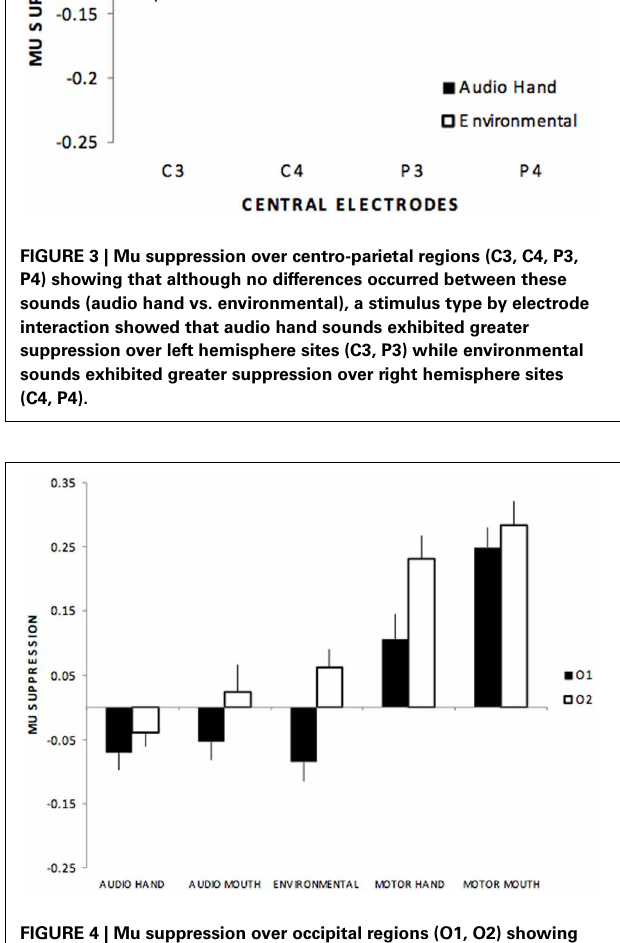
FIGURE 4 | Mu suppression over occipital regions (O1, O2) showing suppression over left (O1) while there was relative enhancement over right (O2) sites to environmental and motor